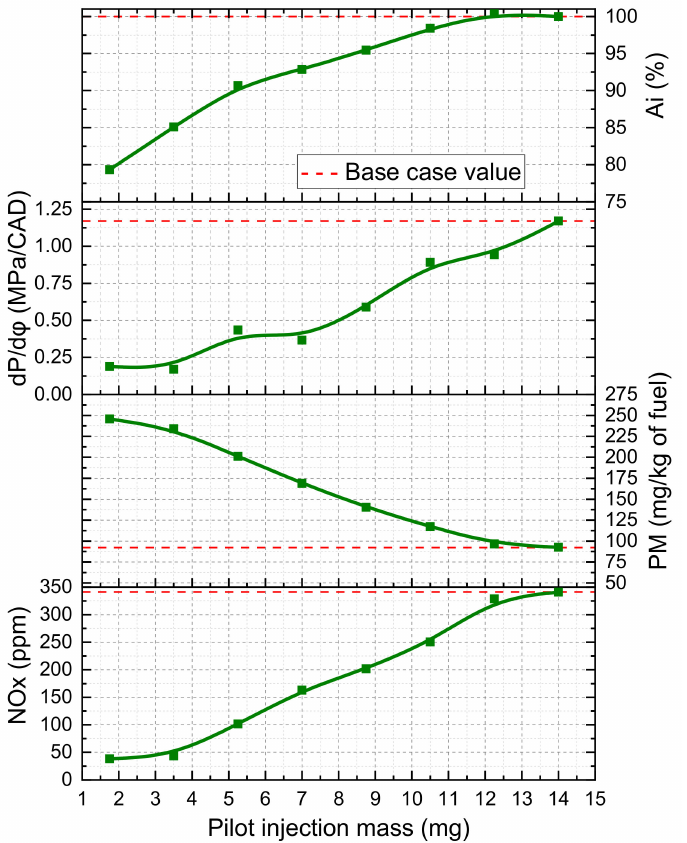
Figure 18. The pilot injection fuel mass variable influence on combustion process and